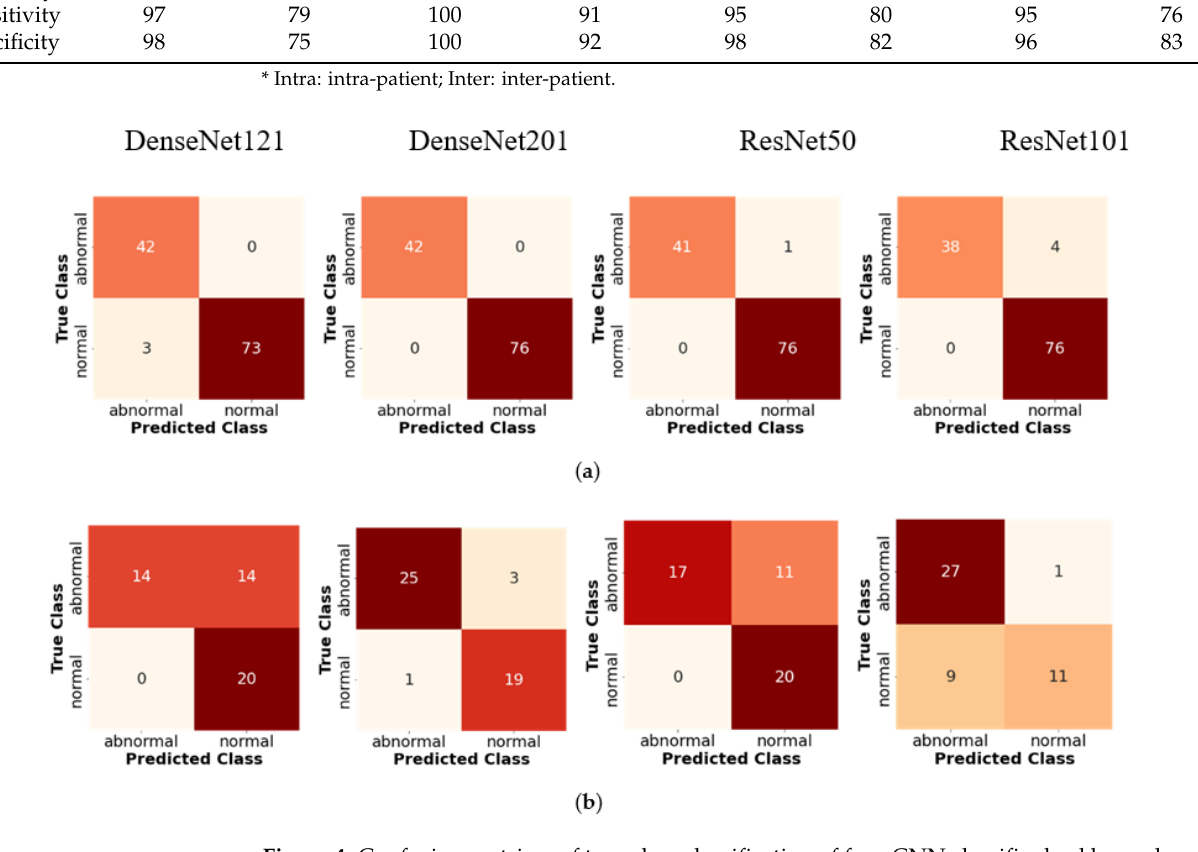
Figure 4. Confusion matrices of two-class classification of four CNN classifier backbones based on intra- and inter-patient scenarios: ( a ) intra-patient validation; ( b ) inter-patient validation.